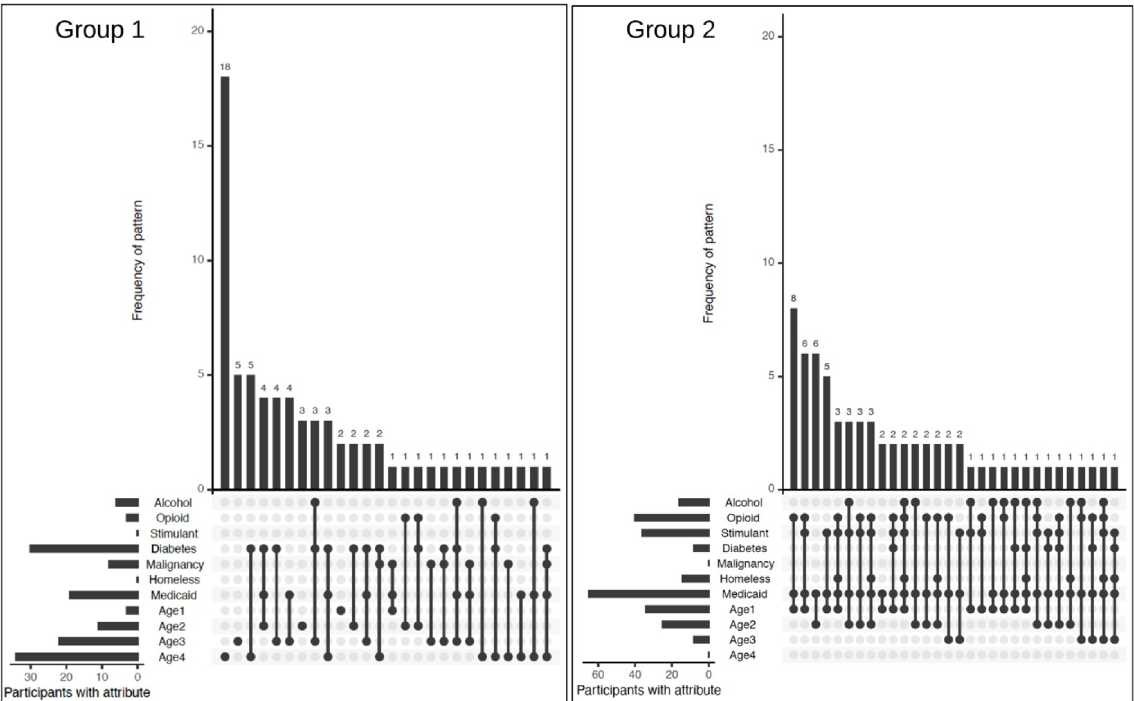
Fig 2. Proportion of patients in each cluster with specific demographic and medical